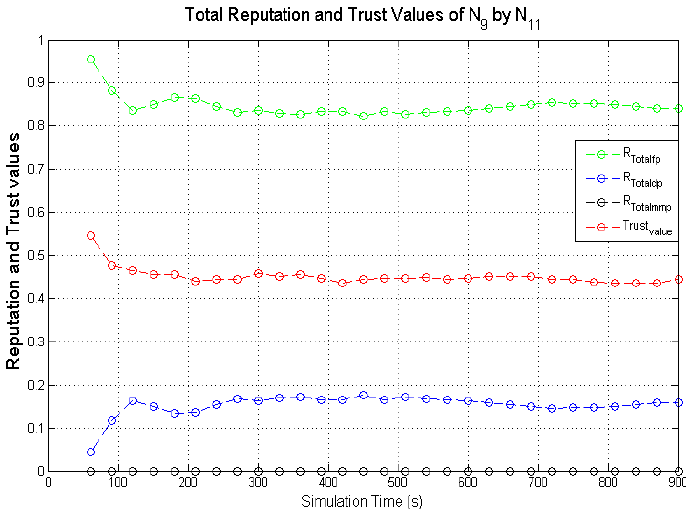
Figure 17. N 9 is benevolent and dishonest, N 11 is selfish and honest.